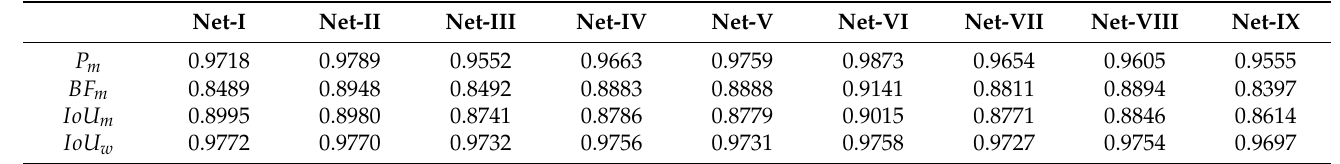
Table 13. Evaluations of validation set with aggregate dataset metrics.